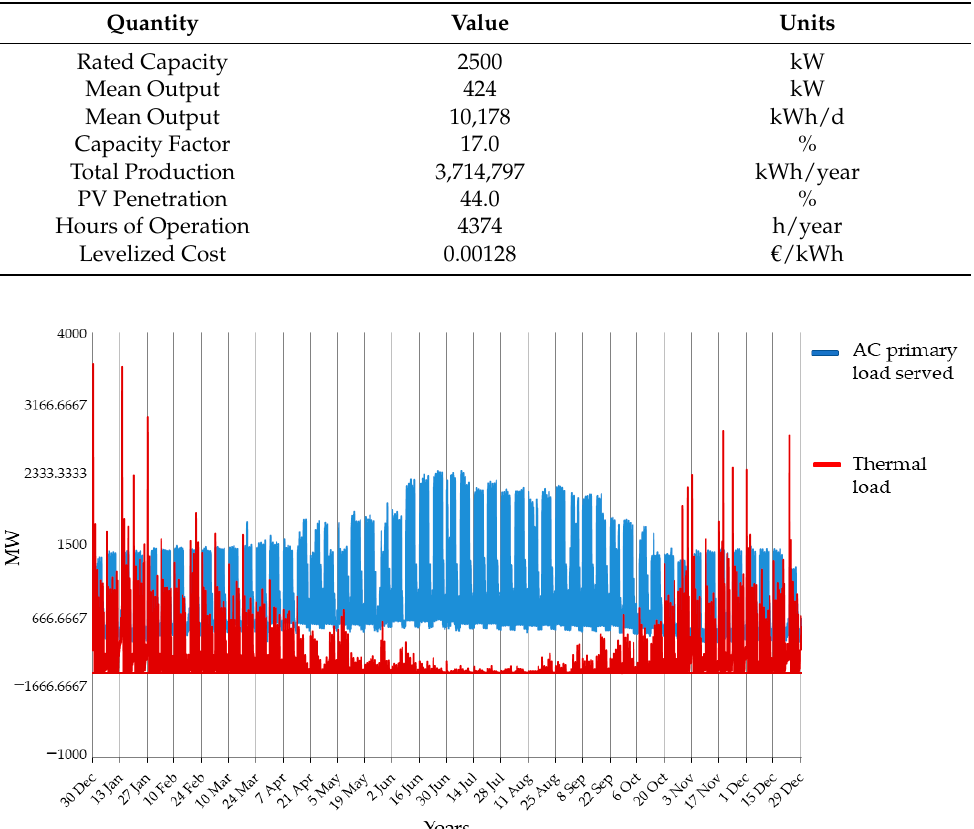
Table 3. Energy demand and grid Table 4. Description of the solar PV system model.